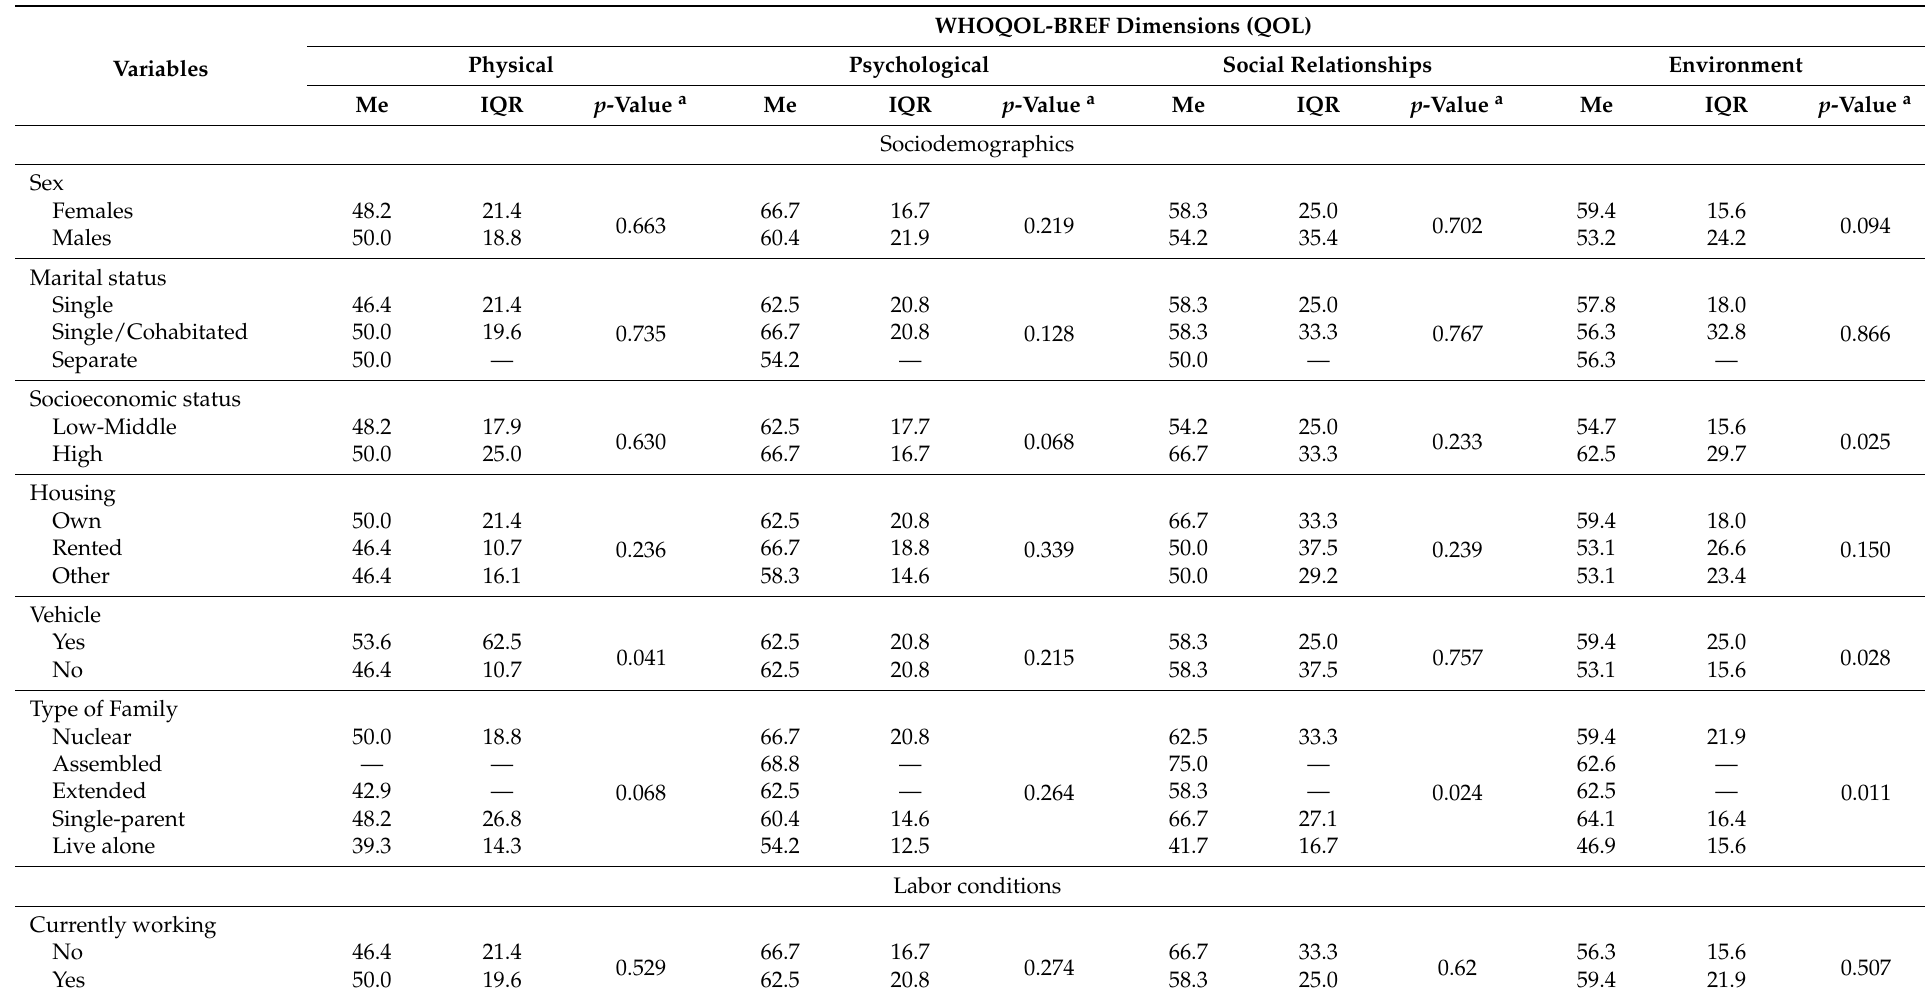
Table 2. Bivariate comparison of the WHOQOL-BREF dimensions of quality of life and the qualitative variables in the study sample ( n =